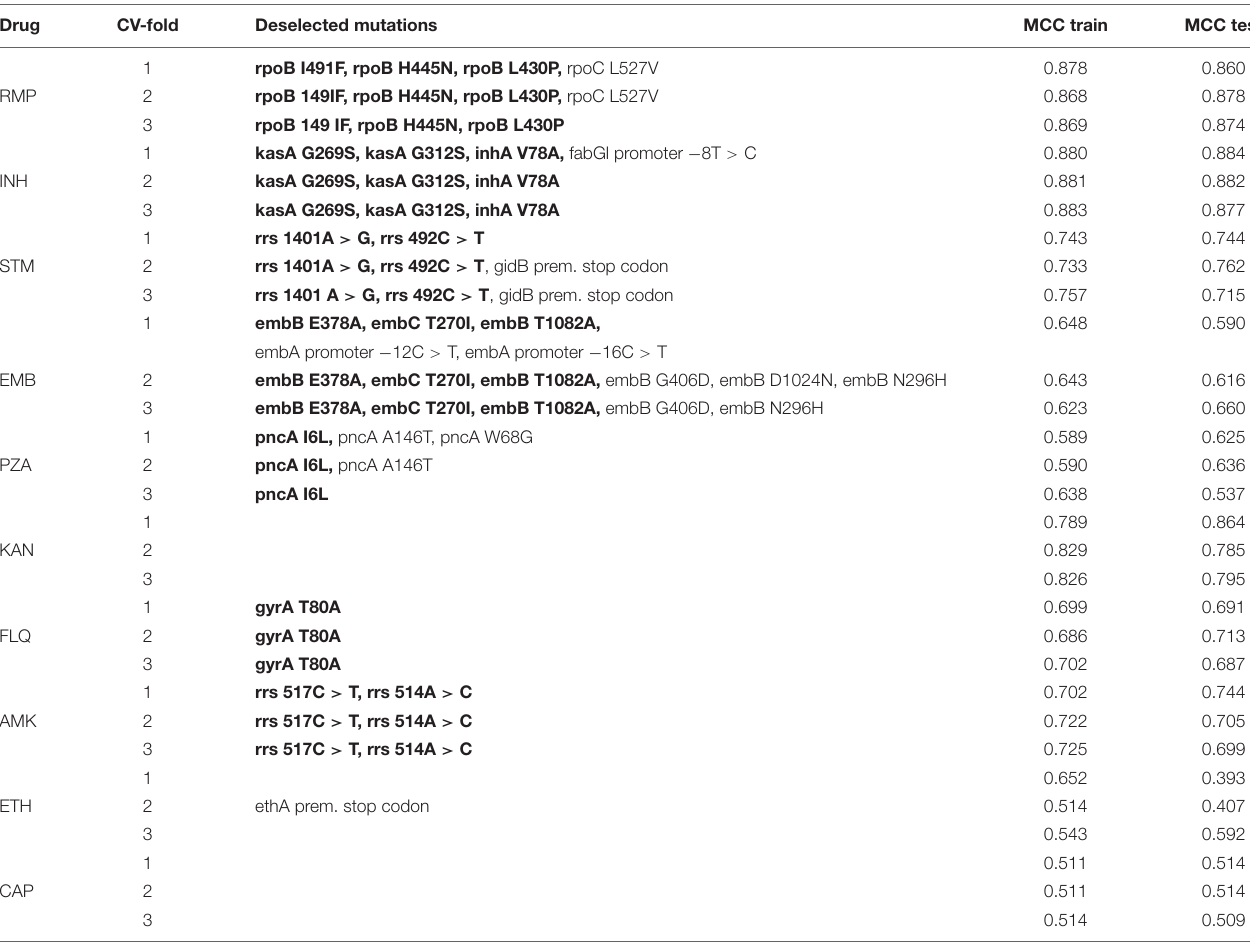
TABLE 5 | Forward feature selection of resistance mutations on the ReSeq data set. Drug